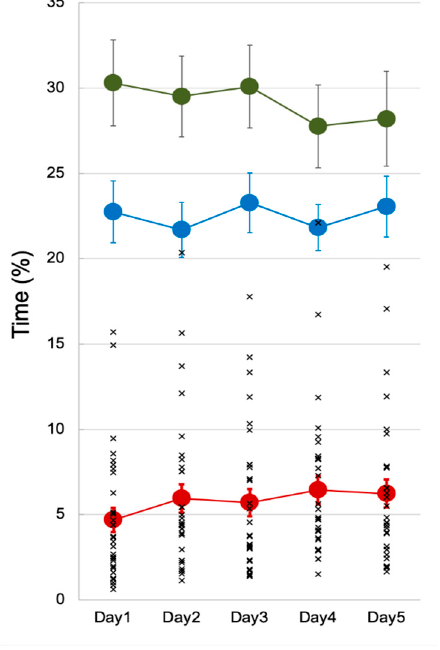
Figure 3. EMA accumulative measurement reactivity. The solid color circles represent the daily average of the time metrics in percentage. Error bars represent standard errors. The cross (x) represents each individual’s TimeR for each day to show a uniform trend of increase observed in the participants. Abbreviations: TimeR = time duration of the unimanual right (paretic) arm/hand movement; TimeL = time duration of the unimanual left arm/hand movement; TimeB = time duration of the bilateral arms/hands